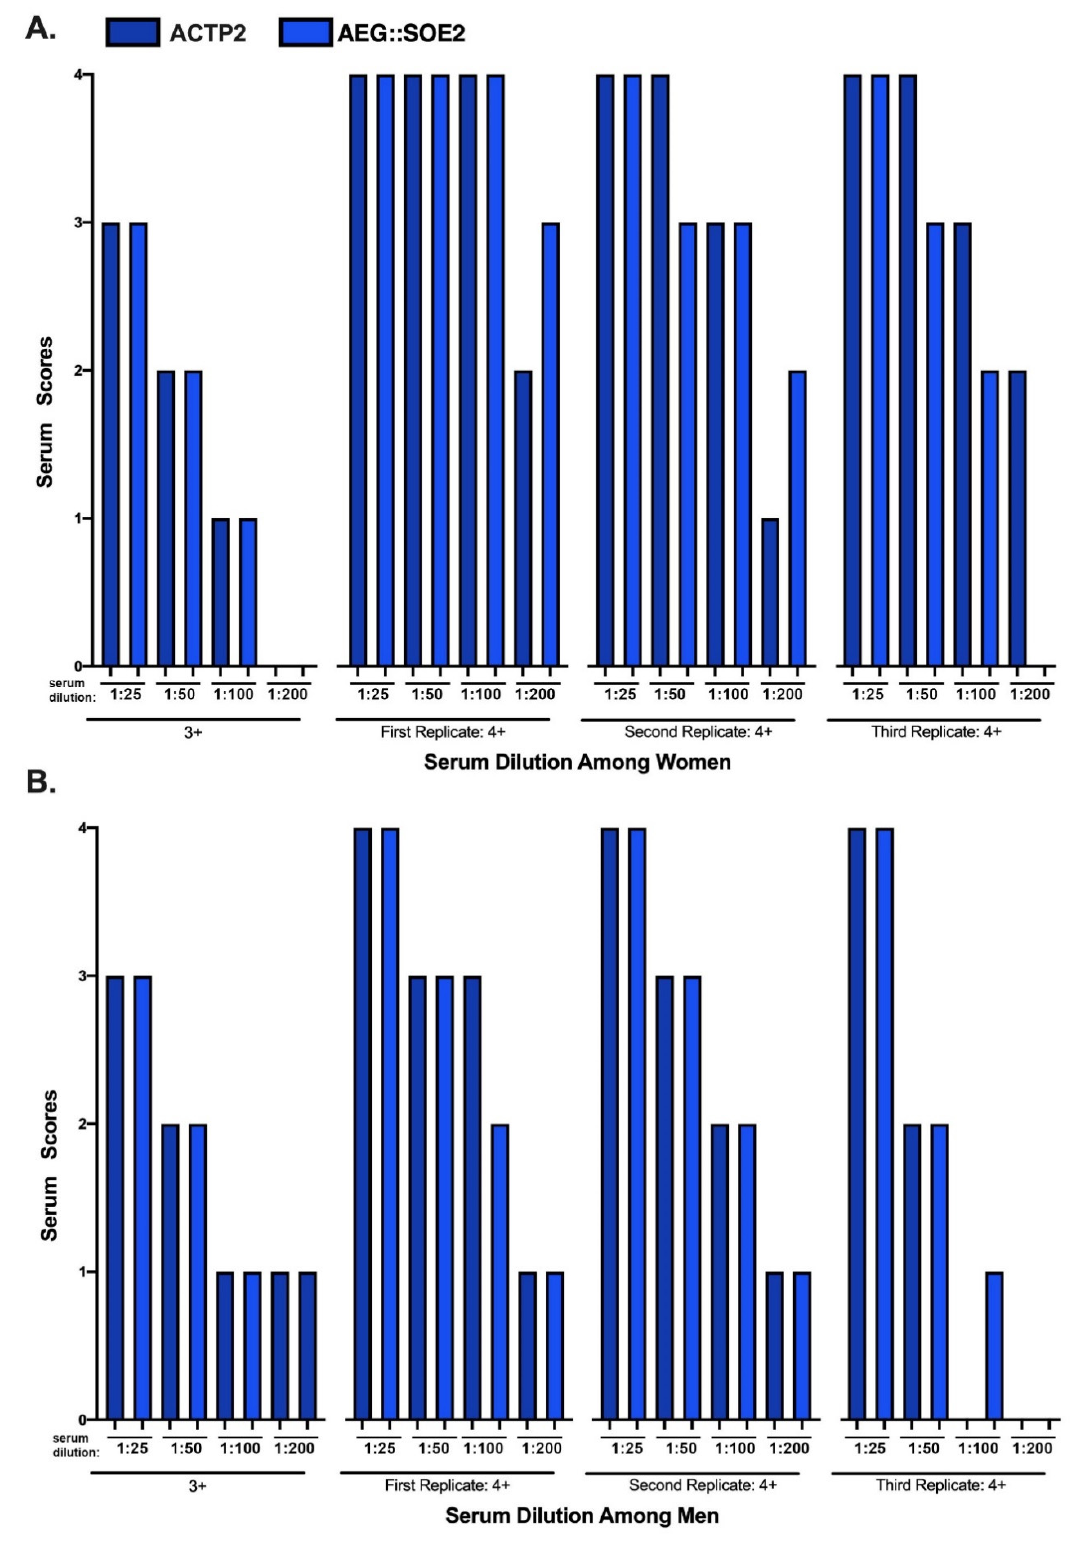
Figure 5. ELISA of women and men sera of 3 + and 4 + scores at di ff erent dilutions. The sera designations for 3 + and 4 + scores following ELISA using standards as controls is as described above for Table 2. This scoring enables the comparative examination of dilutions with eBSA-PBS on the relative reactivities against the target ACT-P2 and ACT::SOE2 proteins. Each replicate consists of pooled di ff erent positive sera (n = 10) of women and men.